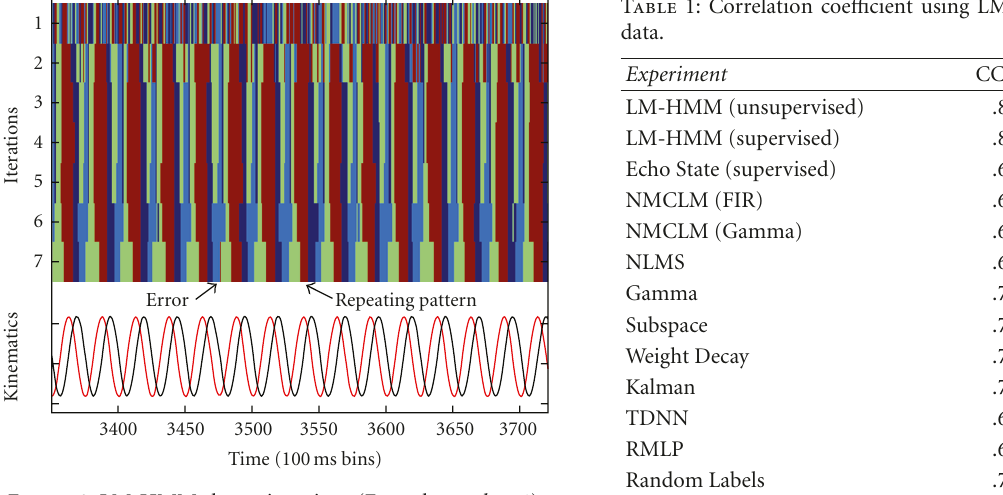
Figure 8: LM-HMM cluster iterations (Four classes, k = 4).